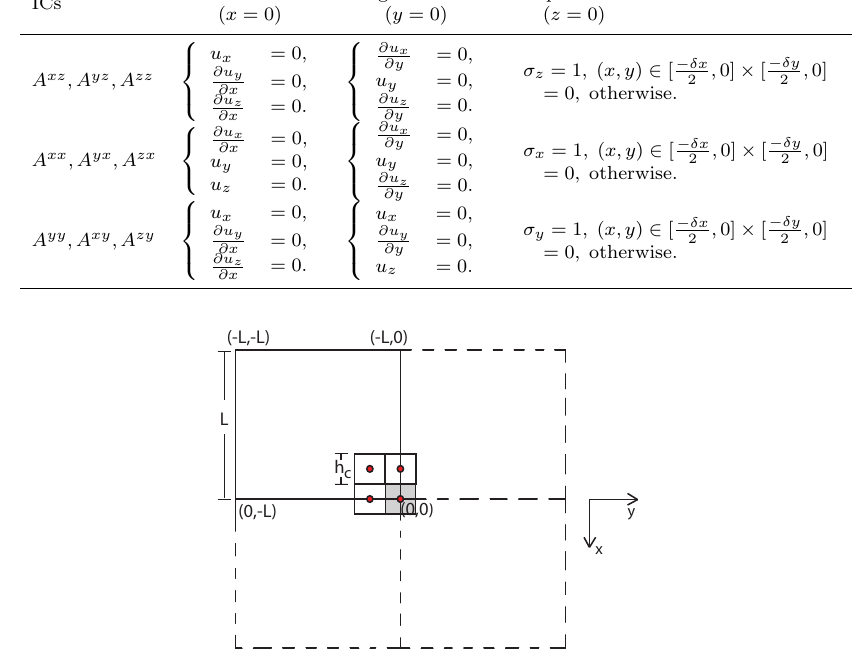
Figure 3. The top surface of the block in the model, for a 2 × 2 contact grid with mesh size h c = δx = δy